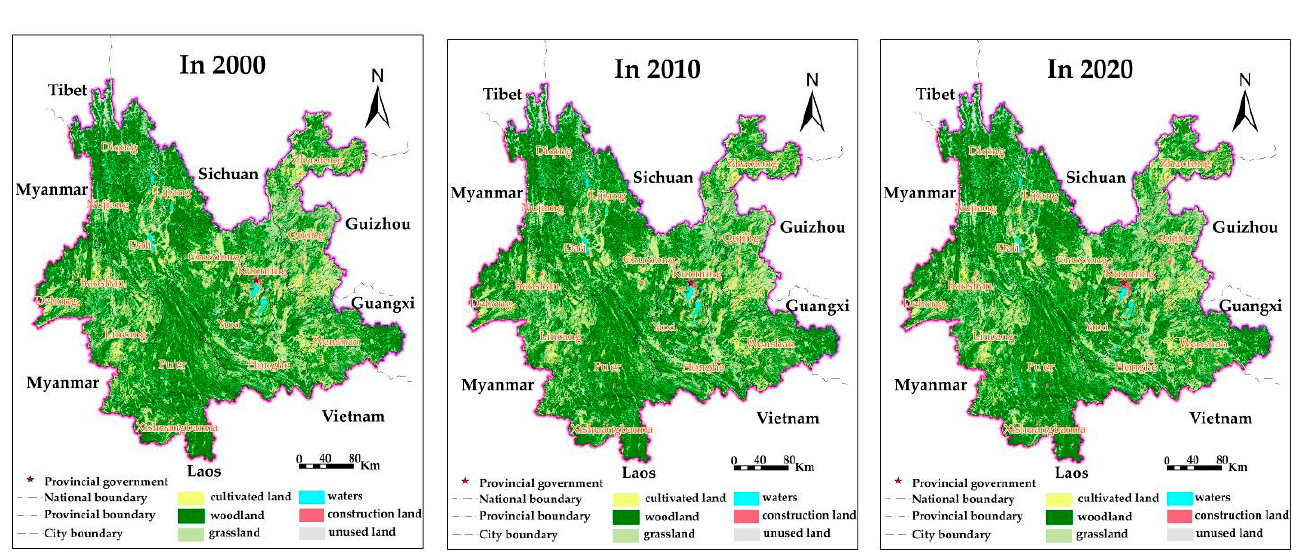
Figure 2. LUCC in 2000, 2010 and 2020.